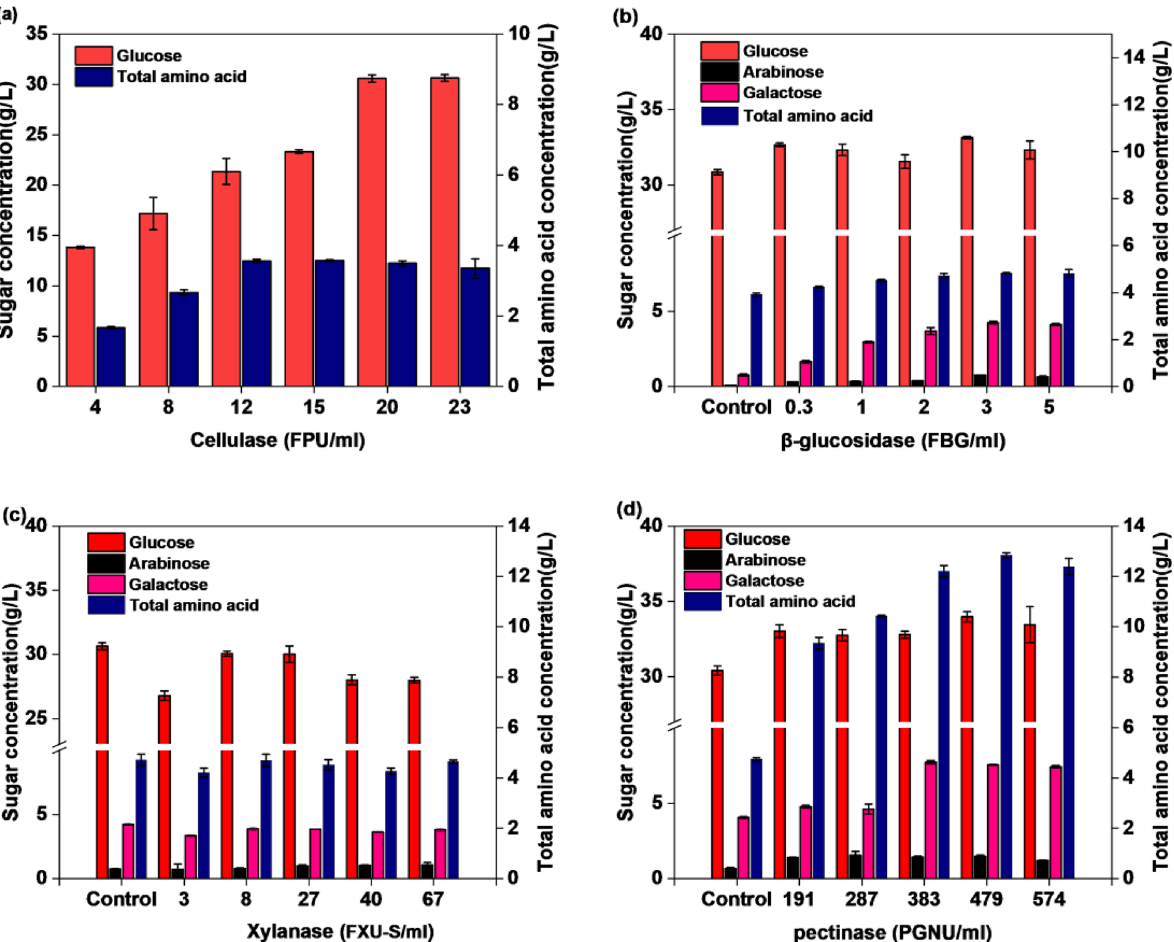
Fig. 2 Effects of addition of cellulase, β-glucosidase, xylanase, and pectinase on the dissolution of monosaccharides and amino acids from okara. a Cellulase; b 20 FPU/mL cellulase and β-glucosidase; c 20 FPU/mL cellulase, 3 FBG/mL β-glucosidase and xylanase; d 20 FPU/mL cellulase, 3 FBG/mL β-glucosidase and